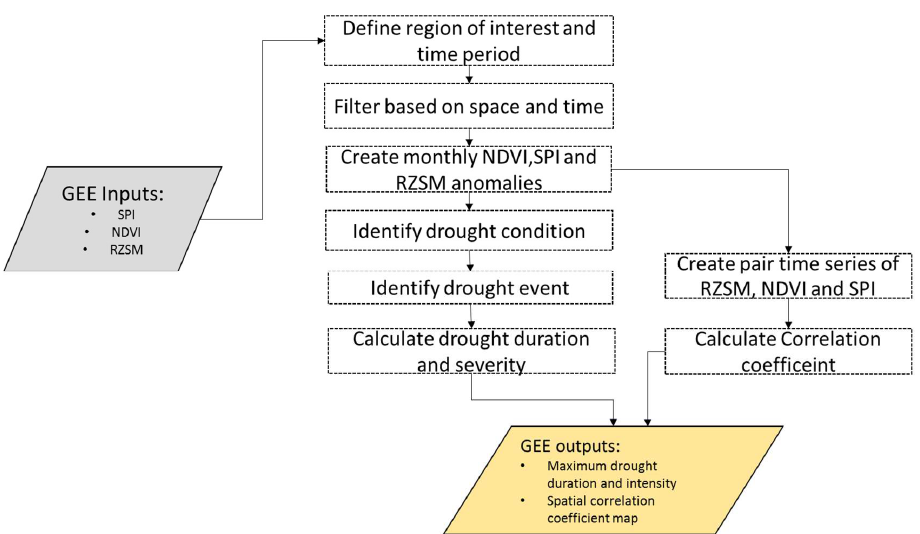
Figure 4 . Data processing steps in the drought assessment routine using the GEE. The gray and gold boxes represent GEE inputs and outputs, respectively. The boxes identified by the dotted lines represent the process that run in the GEE server.